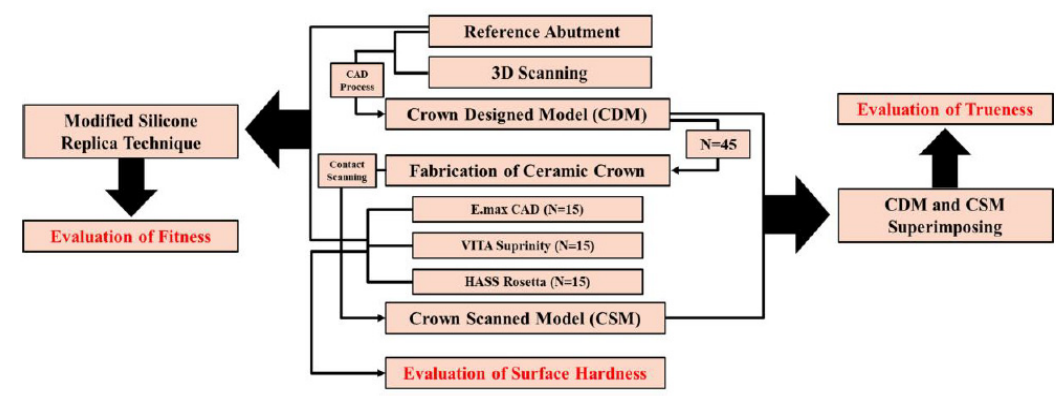
Figure 1. Experimental design.